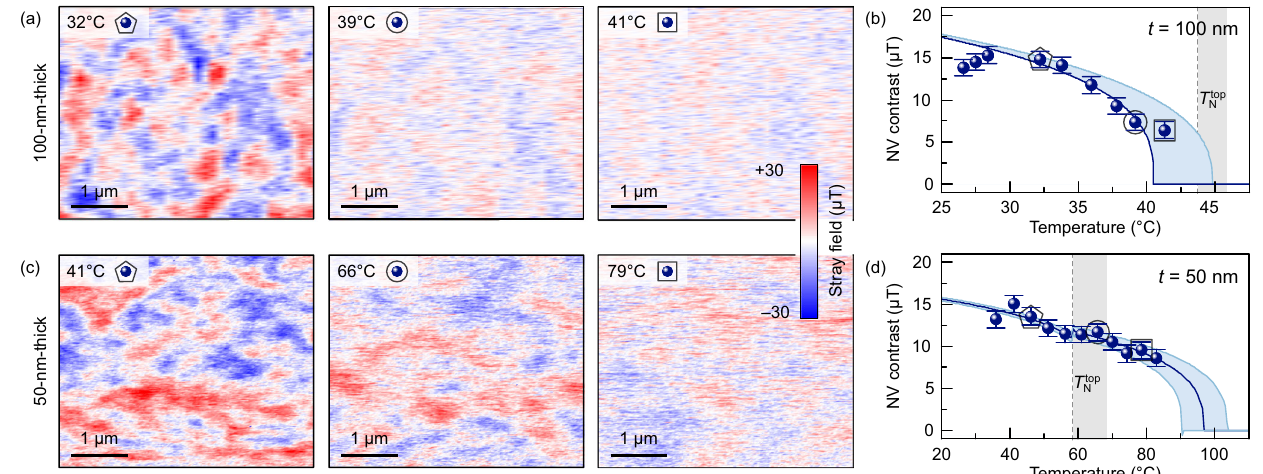
Fig. 3 | Néel temperature of the interior of thin Cr 2 O 3 fi lms. Temperature evo- lutionof the antiferromagneticdomainpatternmeasuredusing NVmagnetometry of ( a ) 100-nm-thick and ( c ) 50-nm-thick Cr 2 O 3 samples. The strength of the mea- sured stray fi eldsdecays upon approaching the transitiontemperature. Estimation of the phase transition temperature at the bottom interface, T bot N , of the ( b ) 100- nm-thick and (d) 50-nm-thick samples. The blue-shaded region in ( b and d ) cor- respondstotheuncertaintyinthedeterminationofthe T bot N .TheNéeltemperature